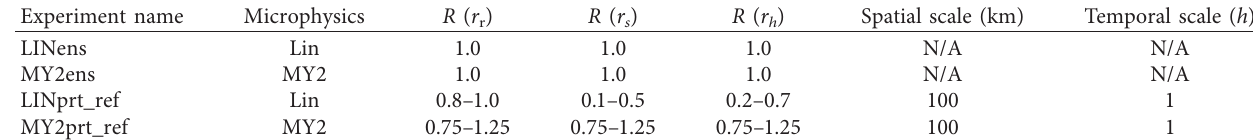
Table 2: Configurations for the Alabama case.